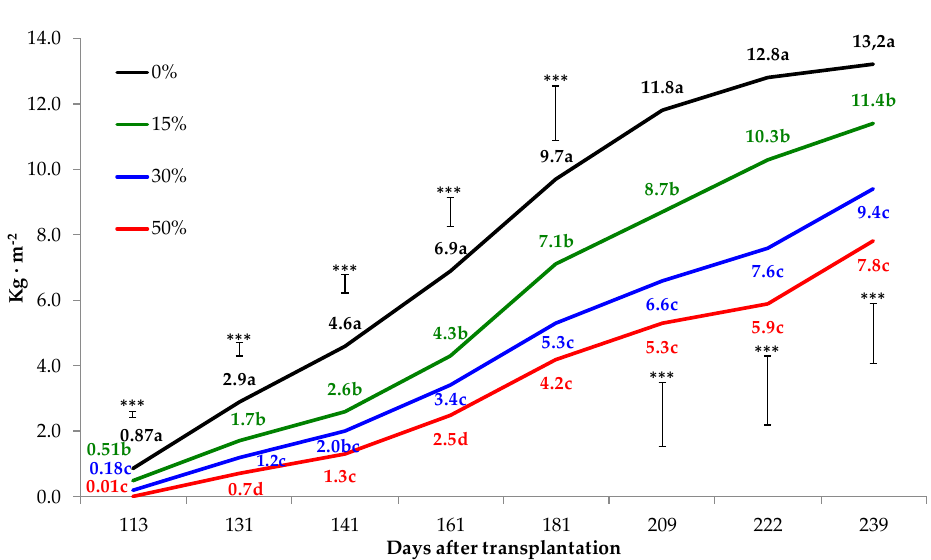
Significance Analysis of the variance is performed according to the Yij model = μ + α i + β j + ε ij. The nomenclature n.s., *, ** and *** indicates not significant or significant for p ≤ 0.05, 0.01 and 0.001, respectively. Numerical values for each column followed by different letters denote statistical significance for p <0.05 according to the corrected minimum significant differences (LSD) test.